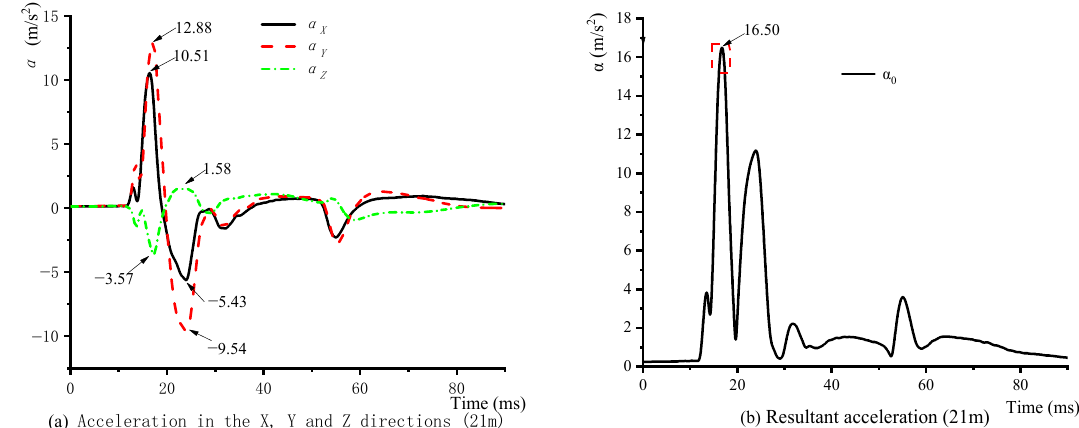
Figure 6. Acceleration data measured at 42 m in the one-ton TNT ground explosion test. It may be observed from Figures 5a and 6a that the maximum positive and negative acceleration in the X direction decreased by 88 and 91.9%, respectively, in correspondence with the increase in distance from the blast site from 21 to 42 m. The corresponding de- creases were 94 and 96.8% in the Y direction and 84.1 and 90% in the Z direction, respec- tively. Thus, it is evident that consequent to an explosion, the accelerations induced by the ground shock in the X, Y, and Z directions decreased very significantly with the increase in distance from the blast site. At 21 m, the maximum positive accelerations in the X and Y directions were 6.65 and 8.15 times that in the Z direction. Likewise, the maximum neg- ative accelerations in the X and Y directions were 1.52 and 2.67 times that in the Z direc- tion. At 42 m, the maximum positive accelerations in the X and Y directions were 5.04 and 3.04 times that in the Z direction, while the maximum negative accelerations in the X and Y directions were 1.22 and 0.86 times that in the Z direction. It is apparent that the intensity of the explosion-induced ground shock decreased with the increasing distance from the blast site, and that the accelerations in the X and Y direction were both higher than that in the Z direction. The numerical dominance of the ground-shock-induced accelerations in the X and Y values implies that the structural effects of ground shocks are concentrated in the X and Y direction, while the effects in the Z direction are considerably weaker.